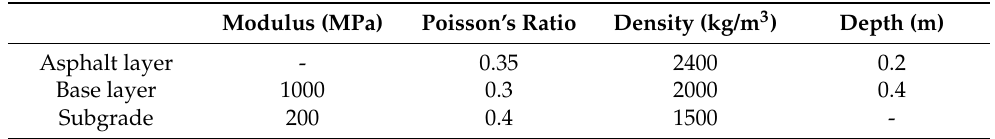
Table 1. Asphalt pavement material and structural